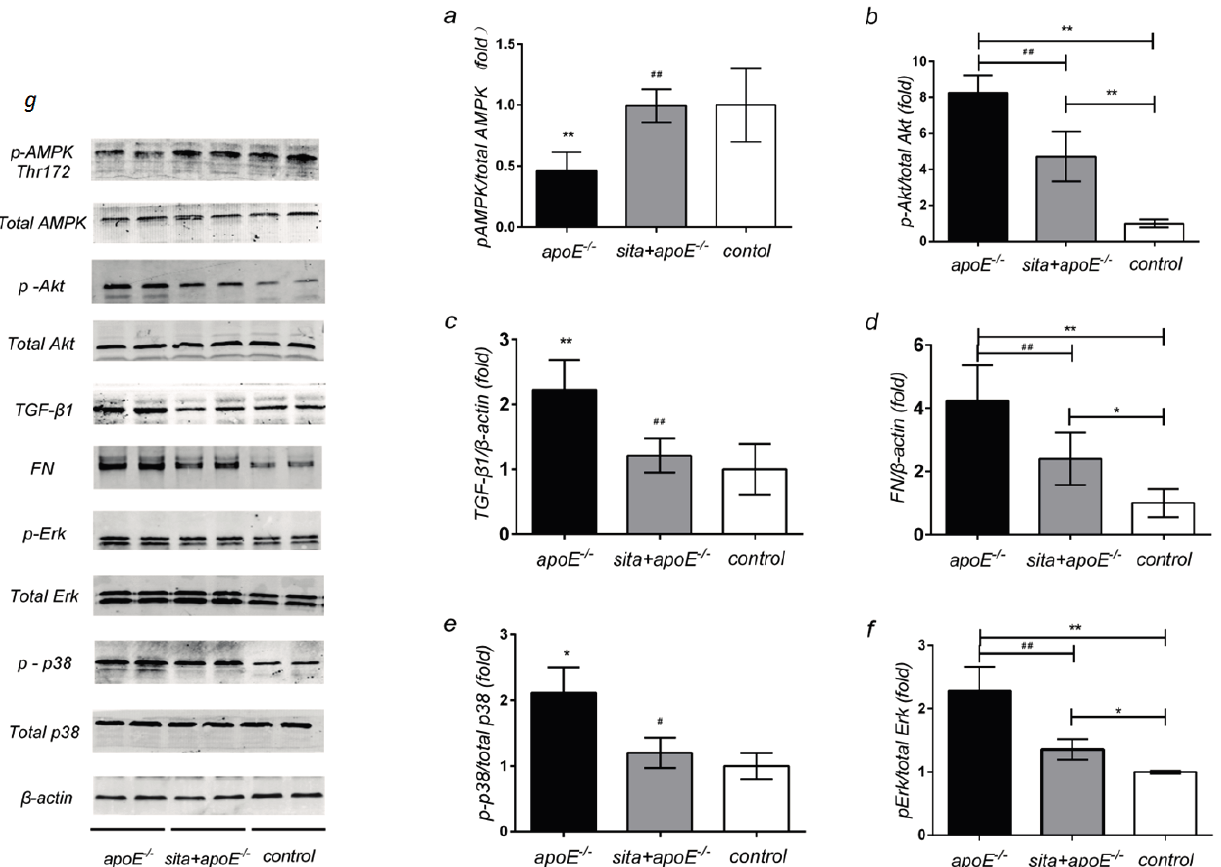
Figure 5. Effect of sitagliptin on renal protein expression of AMPK, Akt, TGF- β 1, FN and MAPK signaling pathway. Protein lysates (30 μ g) from renal cortex were separated by SDS-PAGE and analysed by Western blotting. ApoE − / − , sita + apoE − / − and control mice were analyzed for ( a ) phospho-AMPK/total AMPK; ( b ) phospho-Akt/total Akt; ( c ) TGF- β 1/ β -actin; ( d ) FN/ β -actin; ( e ) phospho-p38/total p38; ( f ) phospho-ERK/total ERK levels. Values are means ± S.D. * p < 0.05 and ** p < 0.01 vs. control group, # p < 0.05 and ## p < 0.01 vs. apoE − / − group; ( g ) All the proteins were